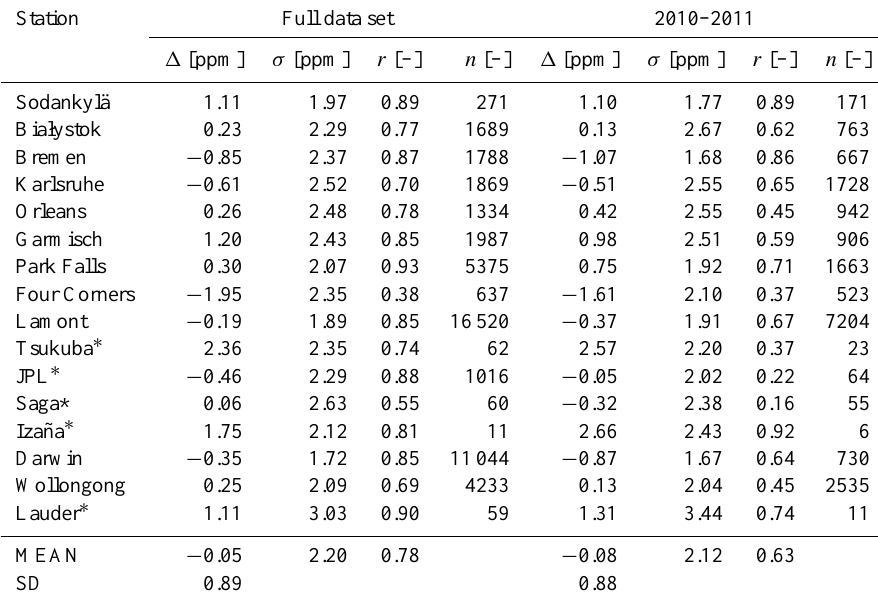
Table 6. As Table 5 but for SCIAMACHY BESD XCO 2 full data set (August 2003–March 2012, see Fig. S2 for the time series) and for a 2010–2011